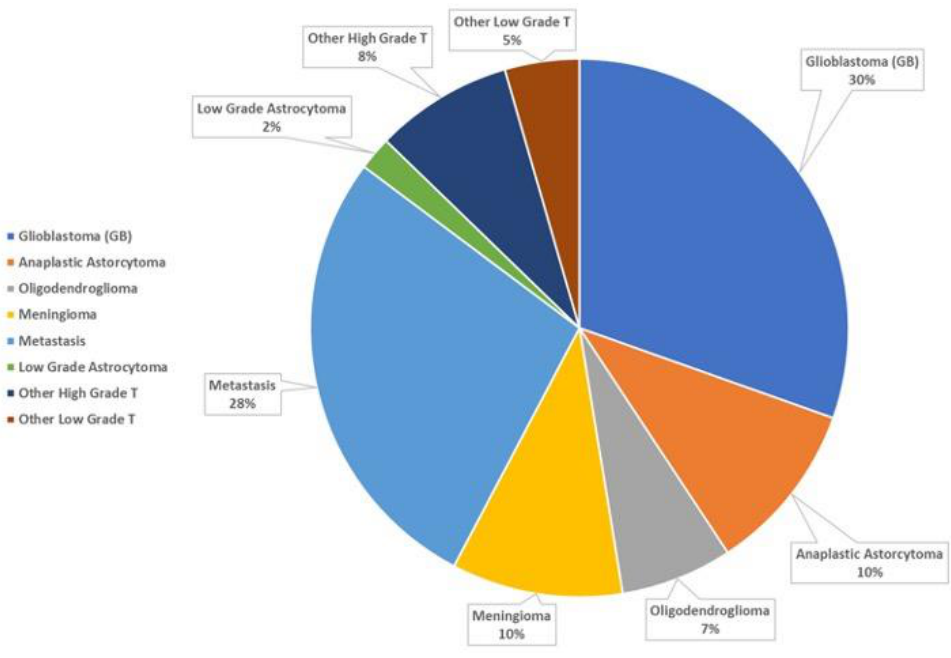
Figure 1. The frequency of the different histotypes of brain tumors discussed over three years at our nMTB. Table 1. Summary table of the role of the physicians attending our nMTB, divided into who proposed the case (requesting) and to whom questions were addressed (recipient).